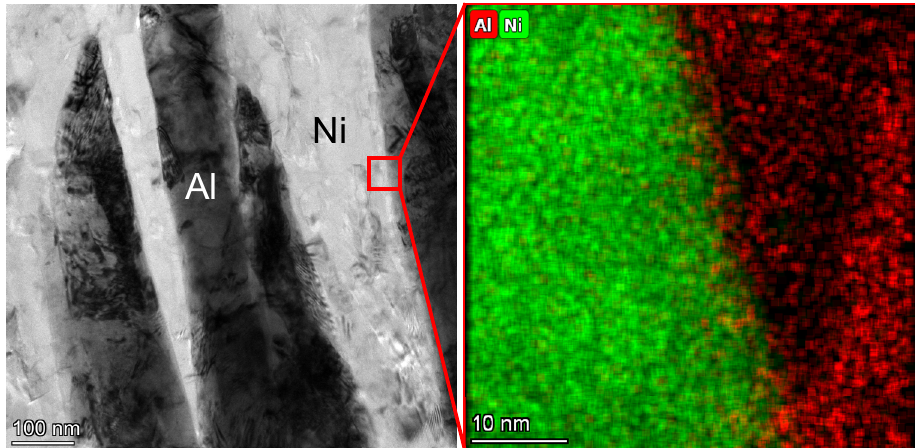
Figure 4. TEM figure of the nanostructured Al/Ni energetic composites.